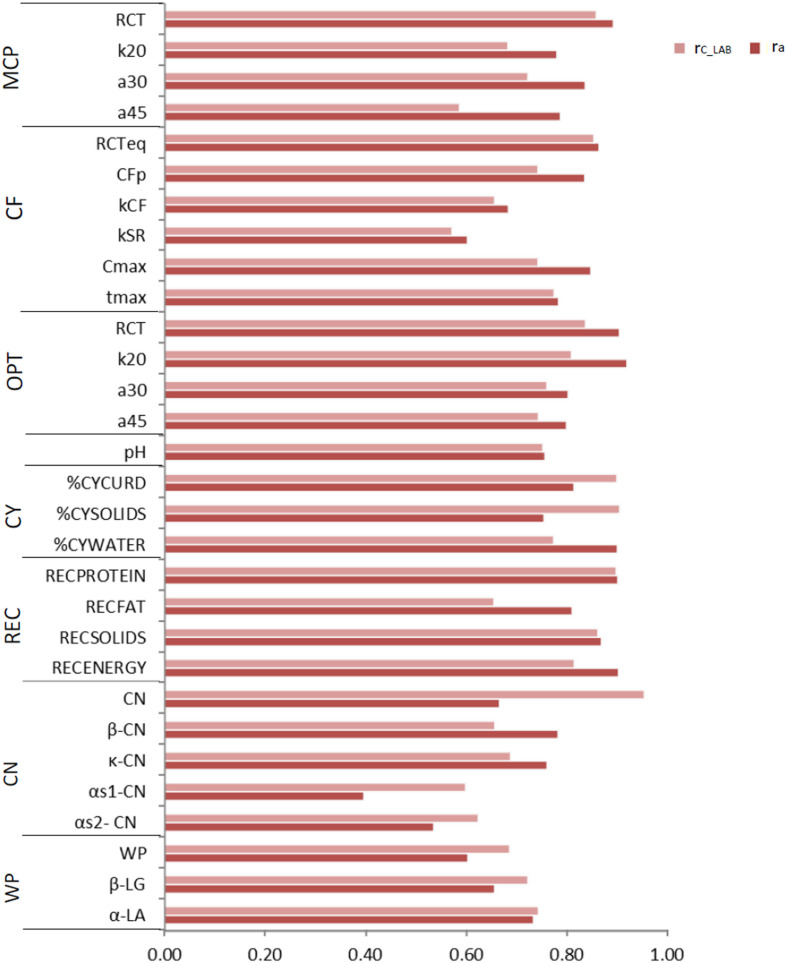
Coefficient of correlation of the calibration models used for infrared prediction (rC_LAB) and additive genetic correlations (ra) between LAB measures and FTIR predictions of the investigated traits using LAB and FIELDlact1 data. MCP = milk coagulation properties; RCT = rennet coagulation time; k20 = curd firming (CF) rate as the time to a curd firmness of 20 mm; a30 (45) = curd firmness at 30 (45) min from rennet addition; RCTeq = rennet coagulation time estimated using the equation; CFP = asymptotic potential curd firmness; kCF = curd firming instant rate constant; kSR = syneresis instant rate constant; CFmax = maximum curd firmness achieved within 45 min; tmax = time at achievement of CFmax; OPT = Optigraph; CY = cheese yield; %CYCURD = weight of fresh curd as percentage of weight of milk processed; %CYSOLIDS = weight of curd solids as percentage of weight of milk processed; %CYWATER = weight of water curd as percentage of weight of milk processed; REC = recoveries; RECPROTEIN = protein of the curd as percentage of the protein of the milk processed; RECFAT = fat of the curd as percentage of the fat of the milk processed; RECSOLIDS = solids of the curd as percentage of the solids of the milk processed; RECENERGY = energy of the curd as percentage of energy of the milk processed. 1True protein nitrogen (N) and milk N fractions are expressed as percentage of total milk N; β-CN (β-casein), κ-CN (κ-casein), αs1-CN (αs1-casein), αs2- CN (αs2-casein); caseins (CN): Σ(β-CN+κ-CN+ αs1-CN+αs2-CN); β-LG (β-lactoglobulin), α-LA (α-lactalbumin), whey proteins (WP): Σ(β-LG+ α-LA).